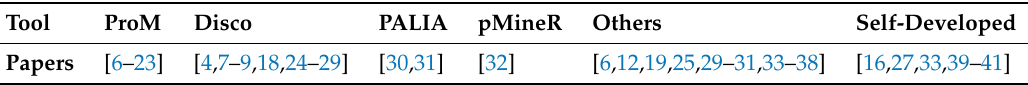
Table 1. Papers with their corresponding Tools most commonly used (non-disjoint). In some papers, other tools were developed or used, resulting in two categories of Others and Self-developed